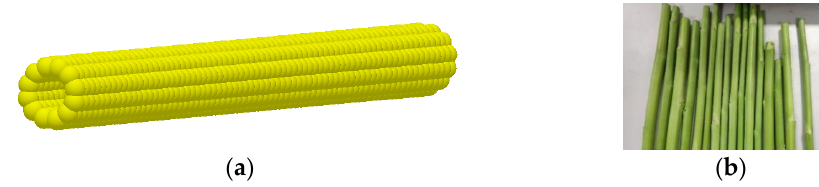
Figure 1. Oilseed rape stalk. ( a ) Model of oilseed rape stalk. ( b ) Actual oilseed rape